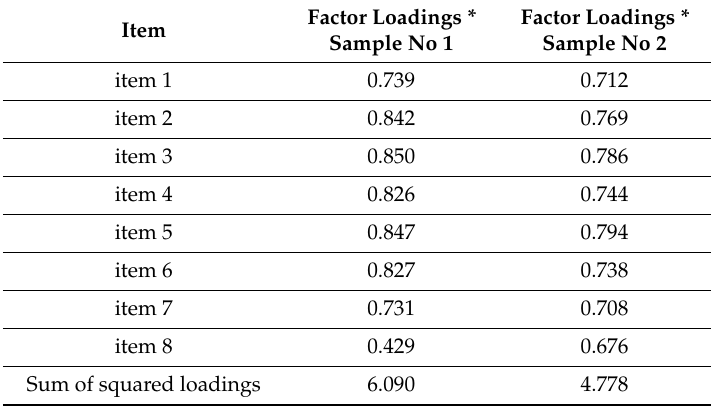
Table 2. Factor loadings and factor score coe ffi cients for the Pl-eHEALS and single extracted factor for Sample No 1 ( n = 489) and Sample No 2 ( n = 1030).